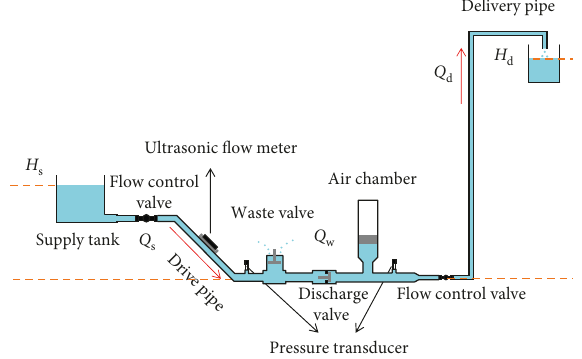
Figure 1: Schematic diagram of the HRP test